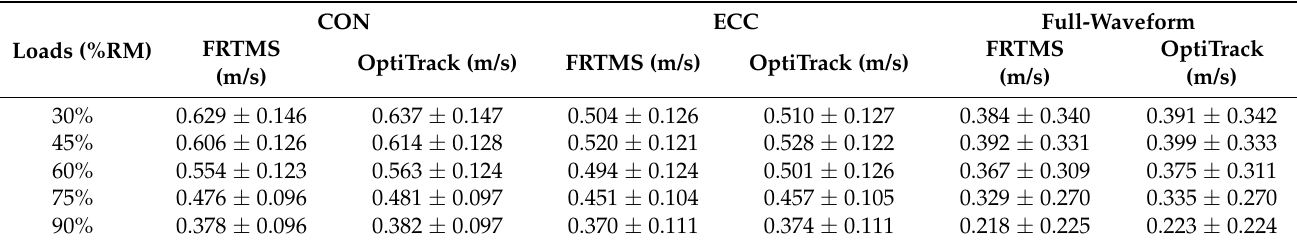
Table 4. Mean values of concentric mean velocity (CON), eccentric mean velocity (ECC), and full- waveform velocity between the FRTMS and the OptiTrack system (OptiTrack) under different loads [means ±